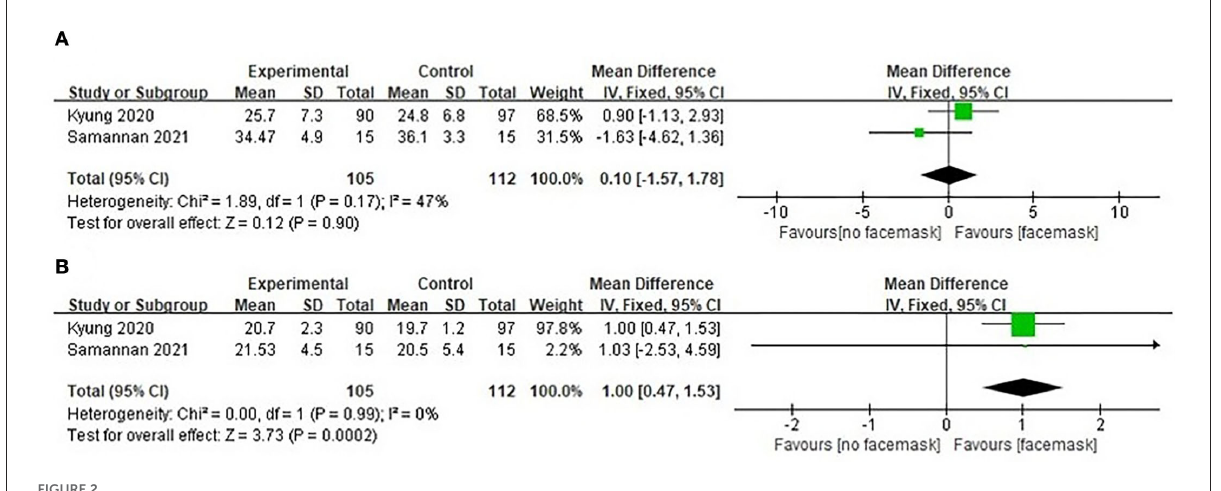
FIGURE2 Forest plot of facemask intervention studies (facemask vs. no-facemask) (A) ETCO2 and (B) RR.